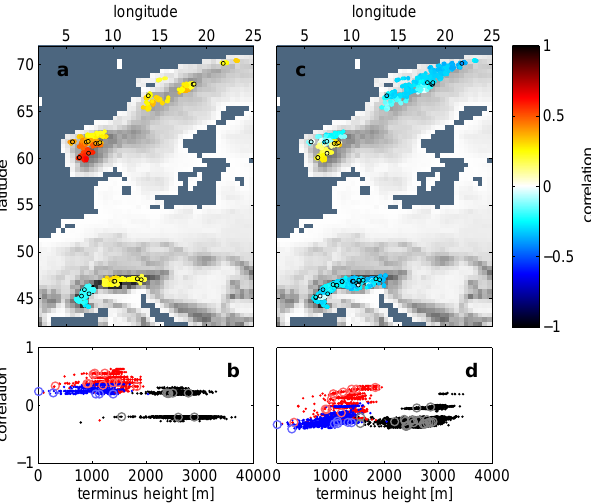
Fig. 11. Correlation between modelled monthly mass balance anomalies obtained using the full variability in the forcing and mod- elled monthly mass balance anomalies obtained using only NAO- related temperature variability and climatological precipitation, i.e., between MB anom and MB (T NAO ,P clim ) (a, b) ; and correlation be- tween modelled monthly mass balance anomalies obtained using the full variability in the forcing, and modelled monthly mass bal- ance anomalies obtained using only NAO-related precipitation vari- ability and climatological temperature, i.e., between MB anom and MB (T clim ,P NAO ) (c, d) . Markers with black circle (a, c) and cir- cle markers (b, d) indicate the results of the glaciers with more than 12 existing measurements of annual mass balance. Values below the 95% confidence interval have been omitted. Gray background shad- ing: topography of the CRU TS 3.0 data. In panels (b) and (d) , black is for glaciers in the Alps, red for glaciers in southern Scandinavia, blue for glaciers in northern